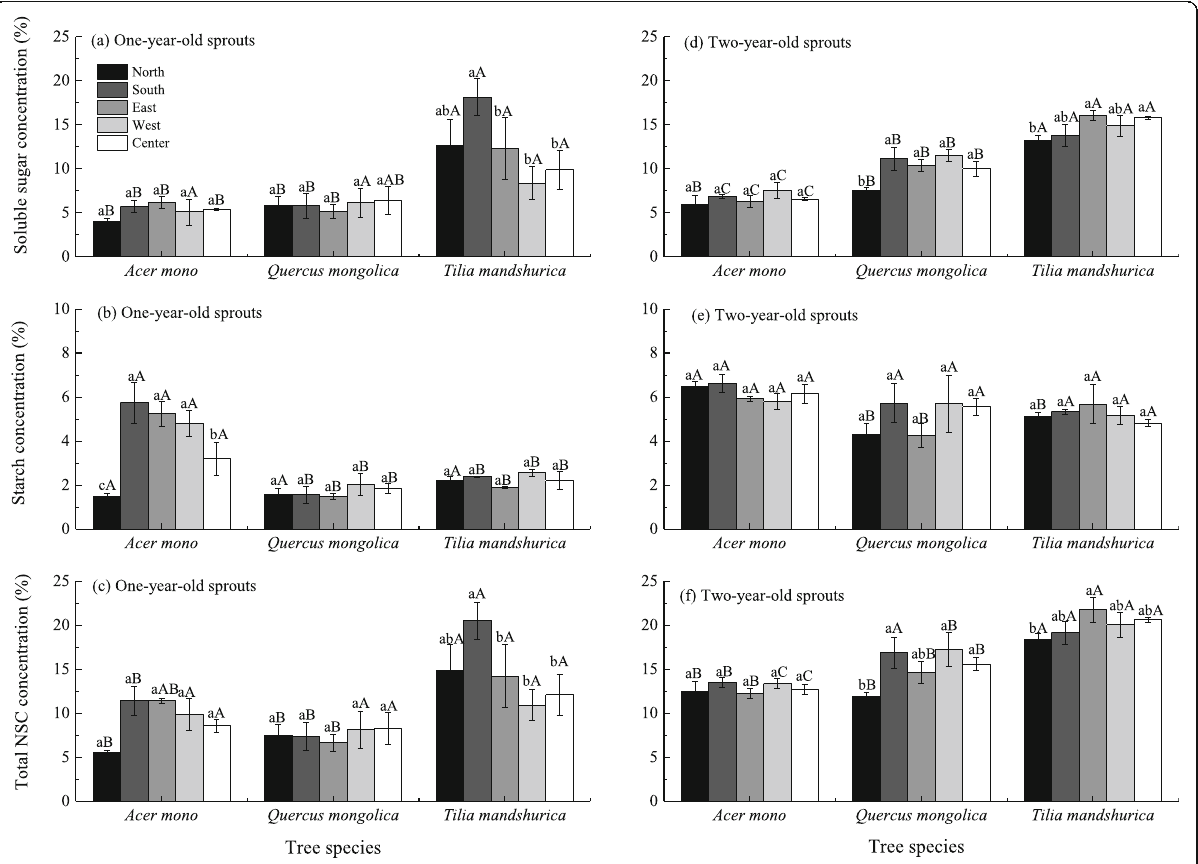
Fig. 4 Concentrations of leaf NSCs (soluble sugar, starch, and total NSC) in 1-year-old and 2-year-old sprouts at different within-gap positions for three tree species. The data are presented as the mean ± S.D. Different capital letters indicate significant differences ( P < 0.05) among tree species. Different lowercase letters indicate significant differences ( P < 0.05) among within-gap